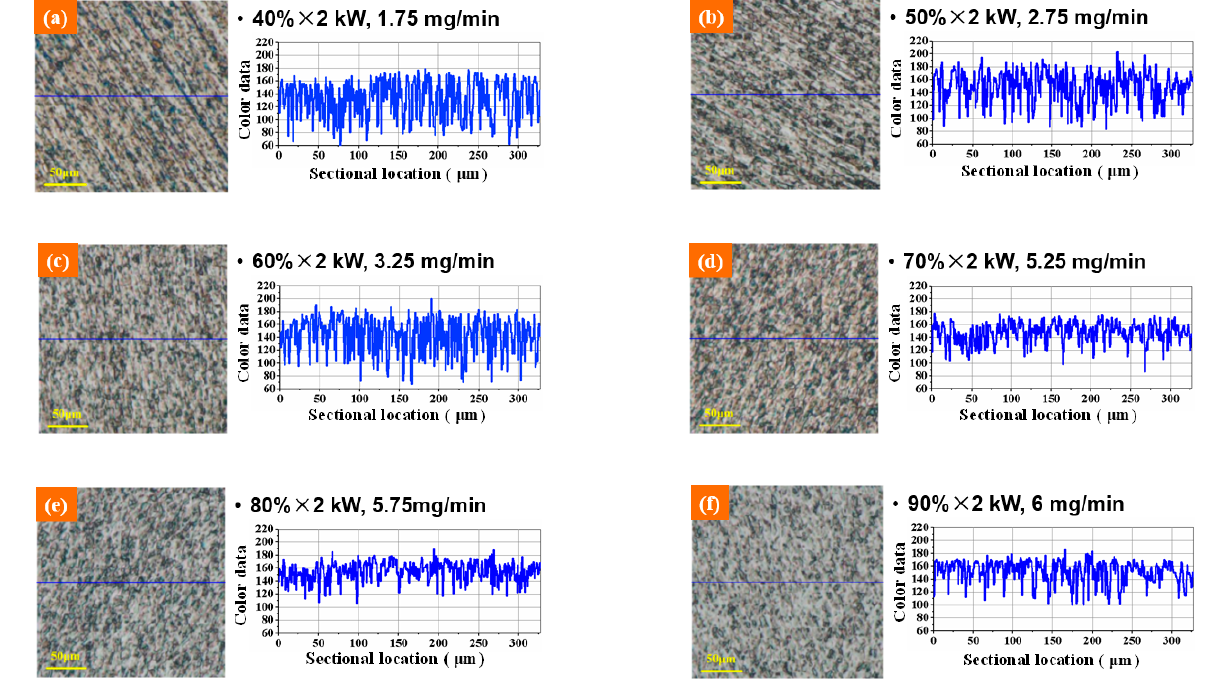
Figure 3. Optical images and sectional surface profiles after ultrasonic vibration-assisted lapping under different amplitudes: ( a ) 40% × 2 kW; ( b ) 50% × 2 kW; ( c ) 60% × 2 kW; ( d ) 70% × 2 kW; ( e ) 80% × 2 kW; ( f ) 90% × 2 kW.